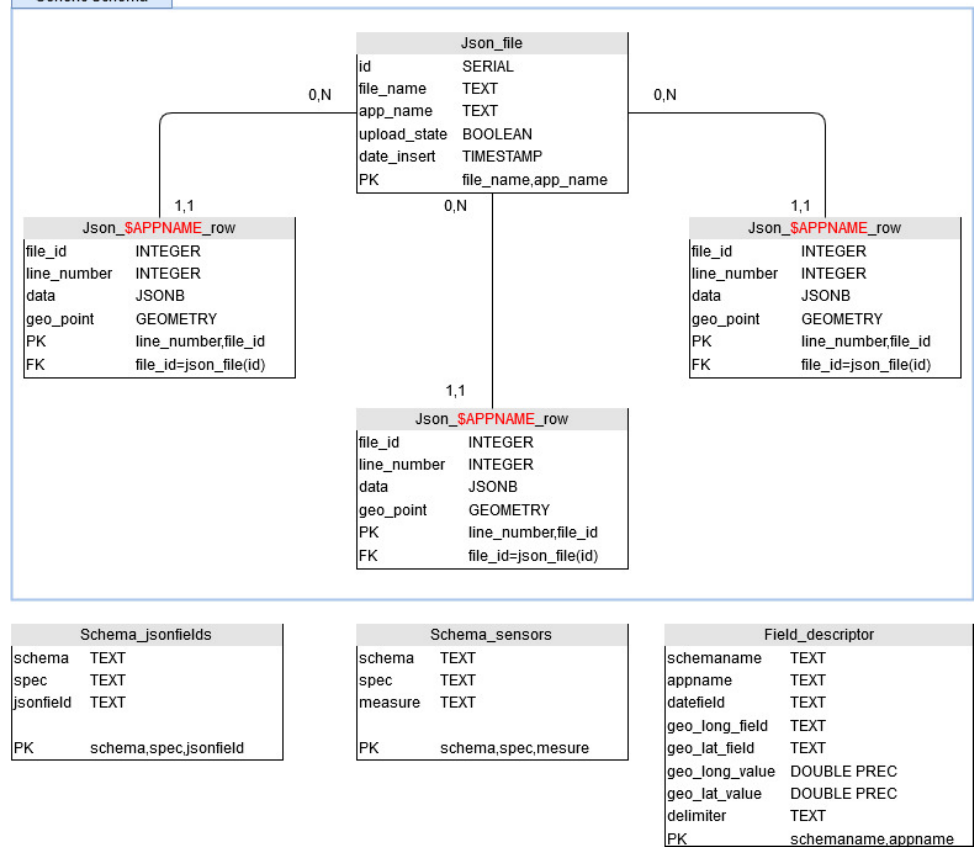
Figure 6. Schema of the